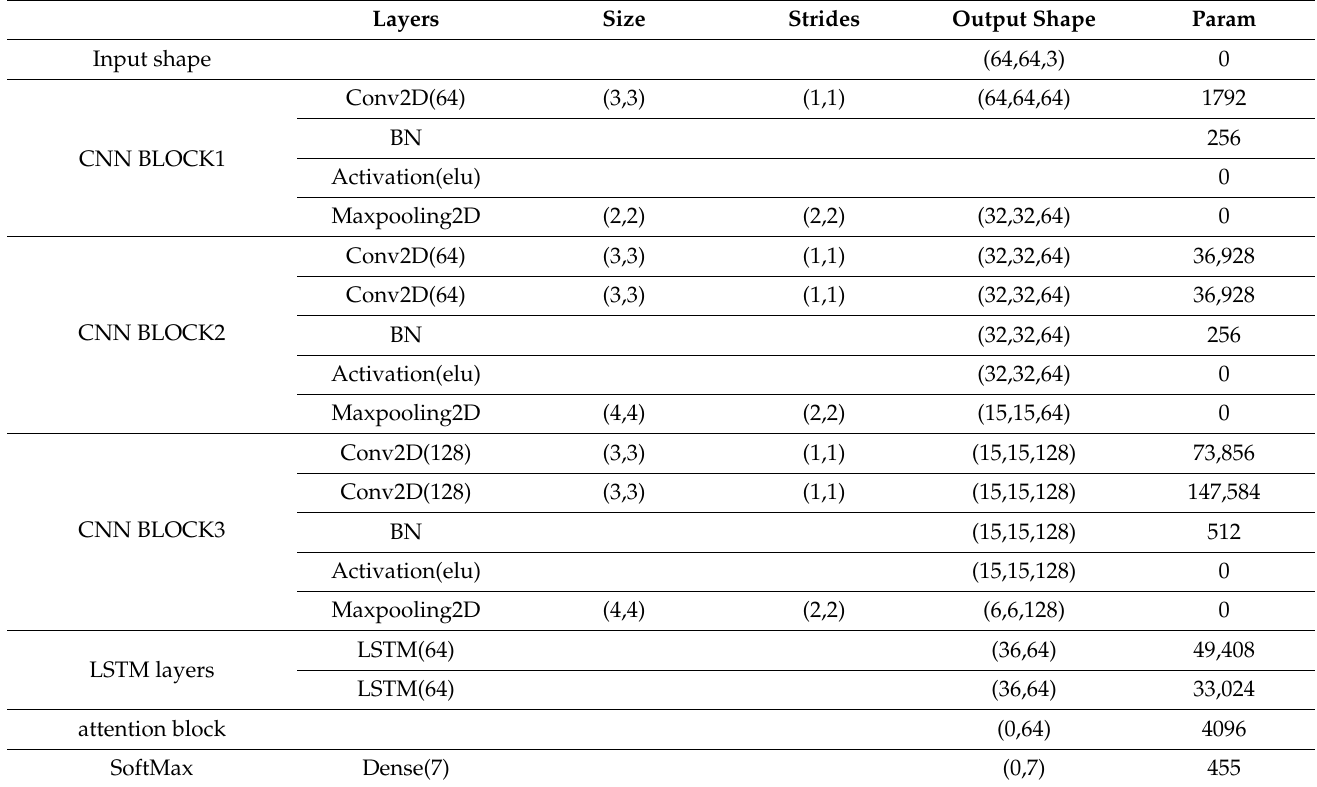
Table 1. The network parameter Settings.